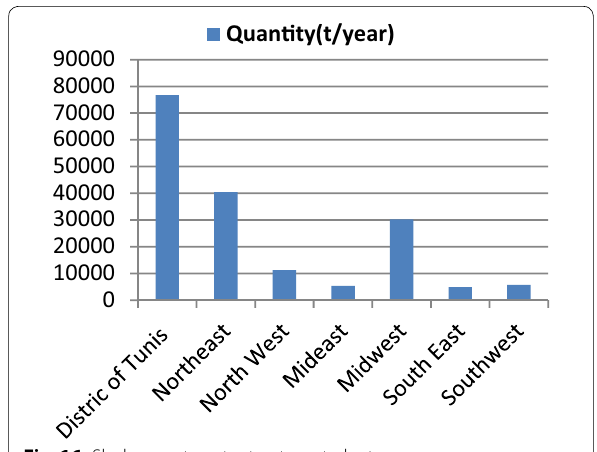
Fig. 16 Sludge wastewater treatment